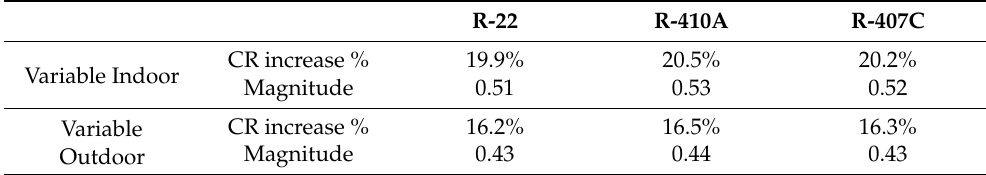
Table 6. Effects of variable outdoor and indoor temperatures on the compression ratio